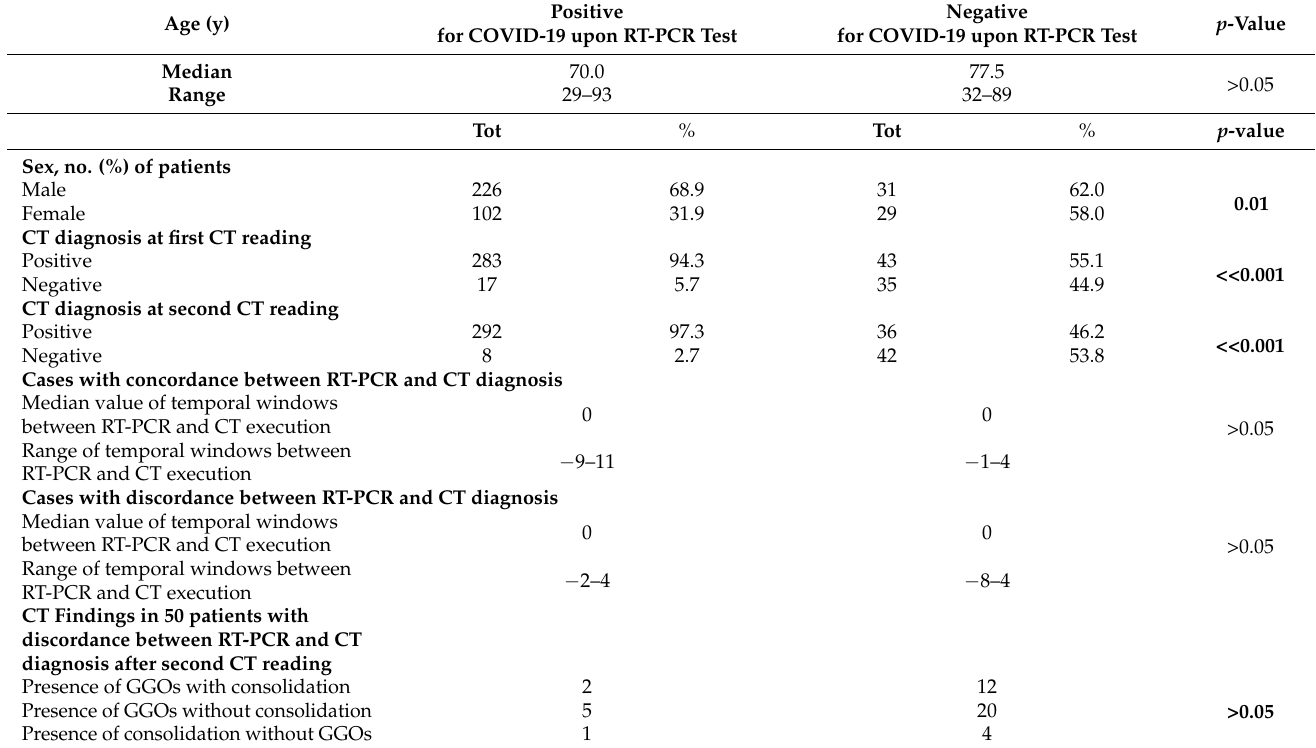
Table 1. Demographic characteristics and CT findings and performance in the detection of pneumonia infection by Coronavirus Disease (COVID-19) in patients with confirmed COVID-19 upon an RT-PCR test. Positive for COVID-19 upon RT-PCR